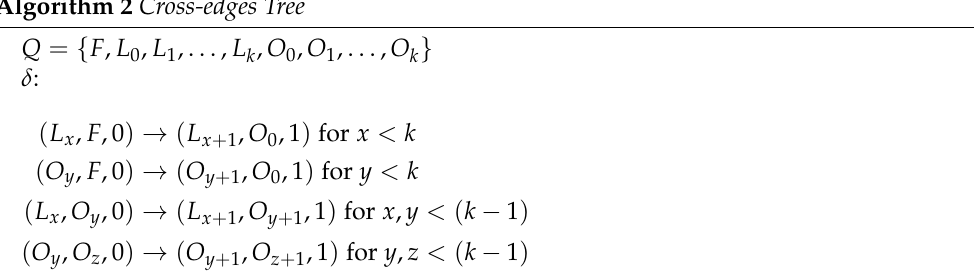
Algorithm 2 Cross-edges